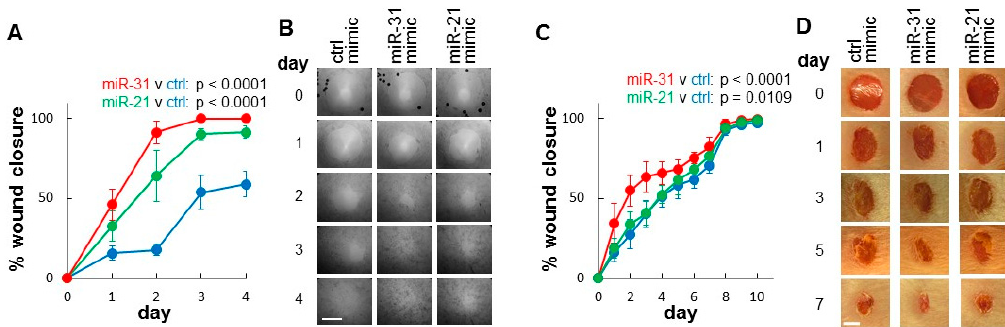
Figure 5. E ff ect of miR-31 and miR-21 on wound closure. ( A ) HaCaT cells were transfected with miR-31 mimic (red), miR-21 mimic (green), or negative control mimic (blue). In vitro wound closure assays ( n = 4) were performed as described in the Material and Methods section. p -values from two-way ANOVA test (for between time course series comparison) are presented. ( B ) Representative images of in vitro wound closure assays taken at the time points indicated. Scale bar = 1 mm. Data represents at least 3 independent experiments with similar results. ( C ) Wound closure ( n = 6) was assessed in vivo as described in the Material and Methods section in mouse skin wounds treated with miR-31 mimic (red), miR-21 mimic (green), or negative control mimic (blue) at the time of injury. p -values from two-way ANOVA test (for between time course series comparison) are presented in the figure. ( D ) Representative photomacrographs of microRNA mimic-treated wounds taken at the time points indicated. Scale bar = 2